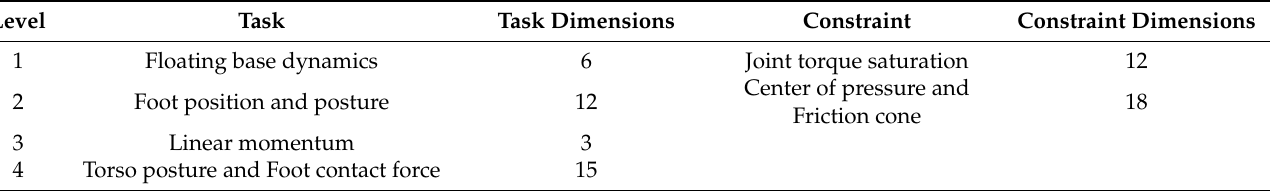
Table 1. Table task constraint